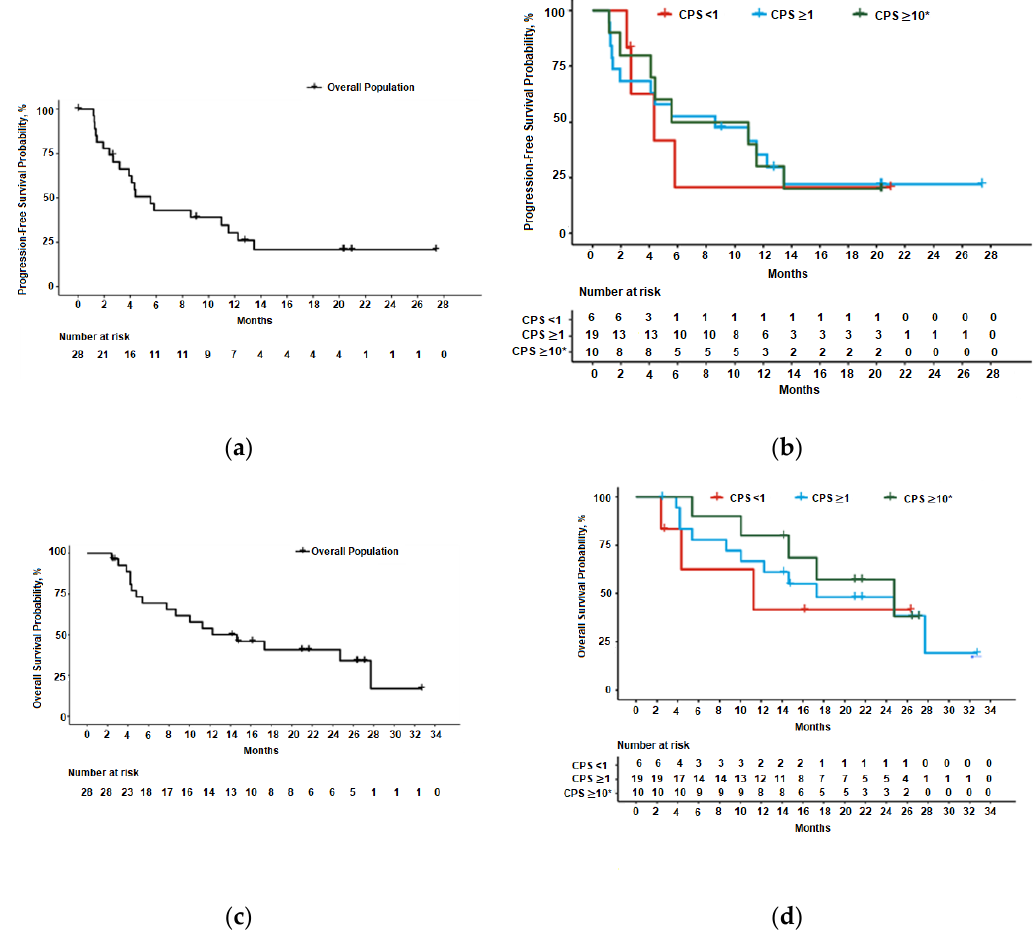
Figure 2. Kaplan-Meier curves of progression-free survival for all patients ( a ) and by PD-L1 status ( b ), and overall survival for all patients ( c ) and by PD-L1 status ( d ). PD-L1-positive is equivalent to CPS ≥ 1 and PD-L1-negative is equivalent to CPS < 1; CPS ≥ 10 is a subset of CPS ≥ 1. Abbreviations: CPS, combined positive score; PD-L1, programmed death-ligand 1.